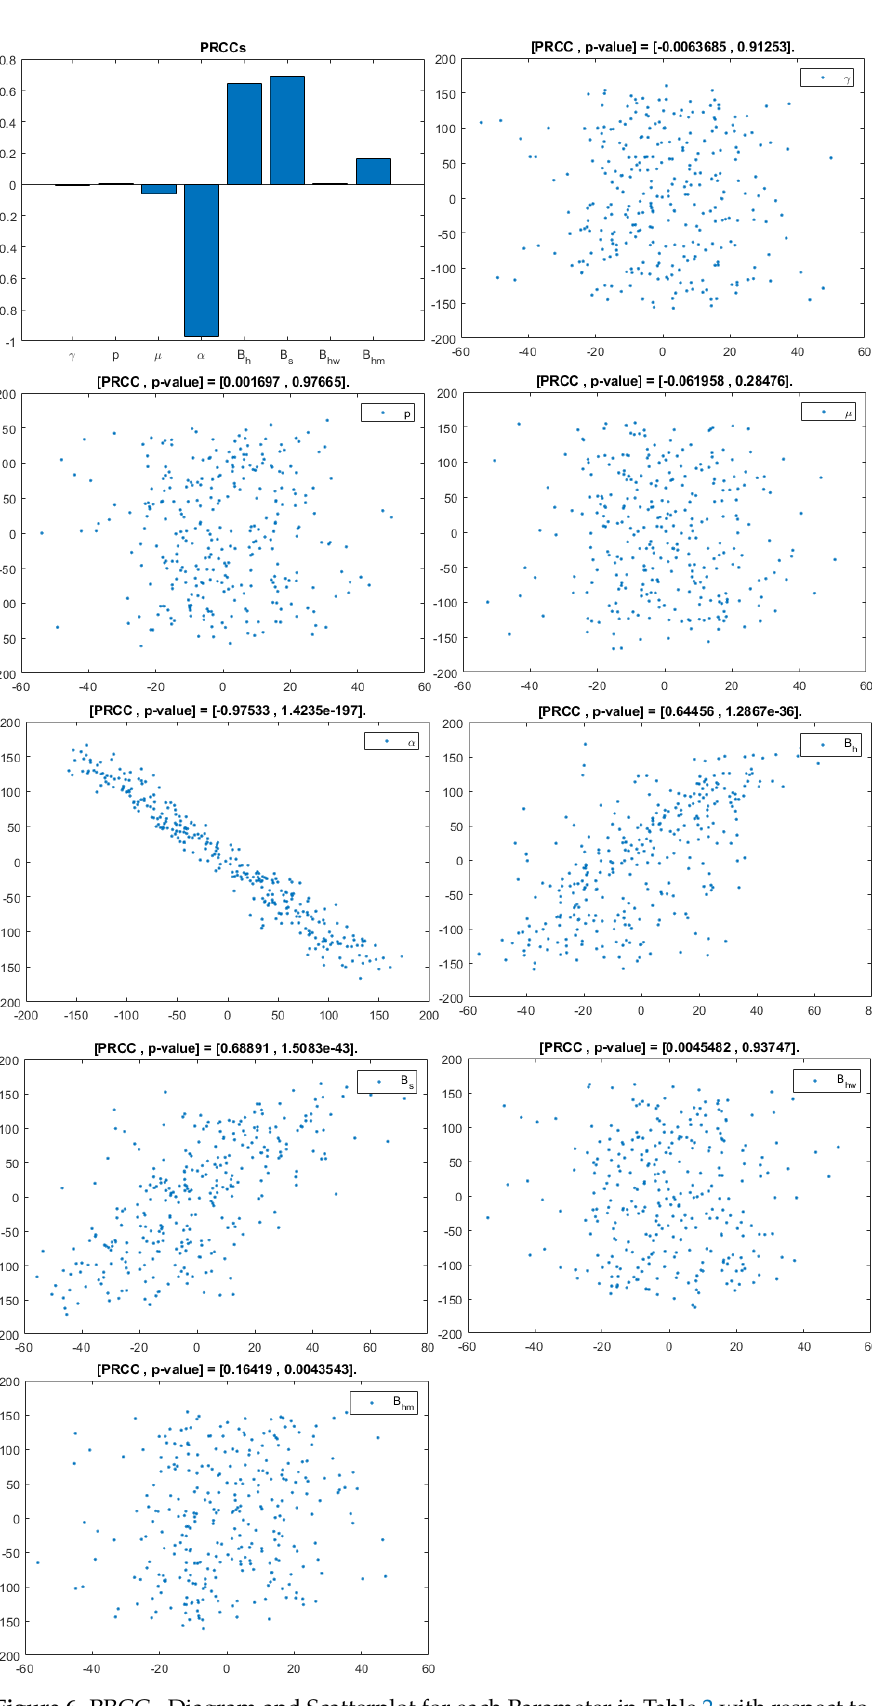
Figure 6. PRCC– Diagram and Scatterplot for each Parameter in Table 2 with respect to Untreated Infected Heterosexual Men, I m